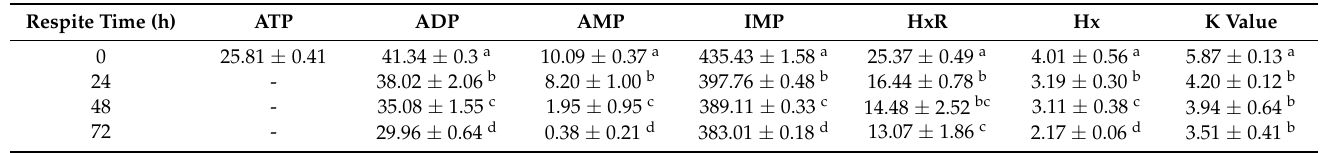
Table 3. The effect of respite time on ATP ‐ related compounds of blunt snout bream after live trans ‐ portation (n = 3 for each respite time).